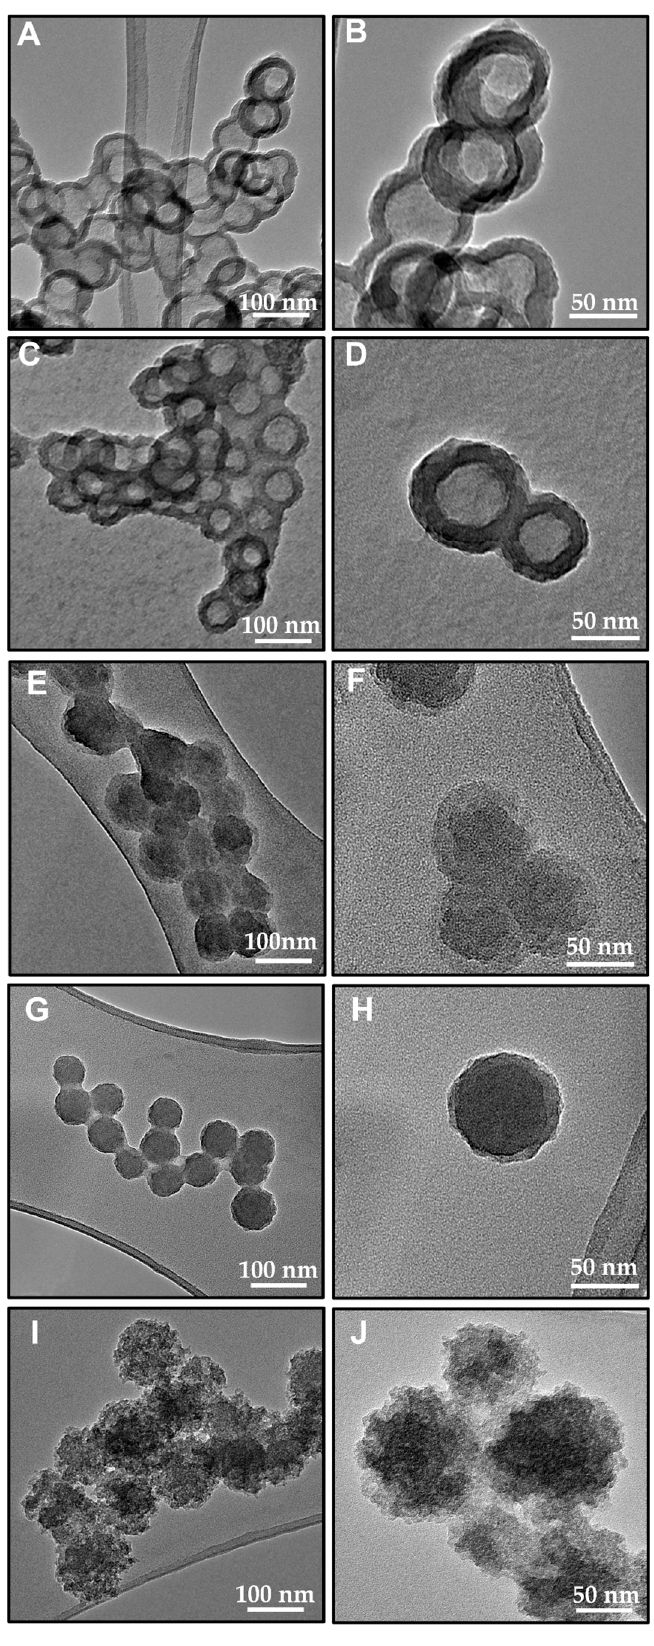
Figure 1. TEM micrographs of SiO 2 -Hep_1 ( A , B ), SiO 2 -Hep_2 ( C , D ), SiO 2 -Hep_3 ( E , F ). SiO 2 -Hep_4 ( G , H ) and SiO 2 -Hep_5 ( I , J ) nanoparticles, taken at lower (left column) and higher (right column) magnification.